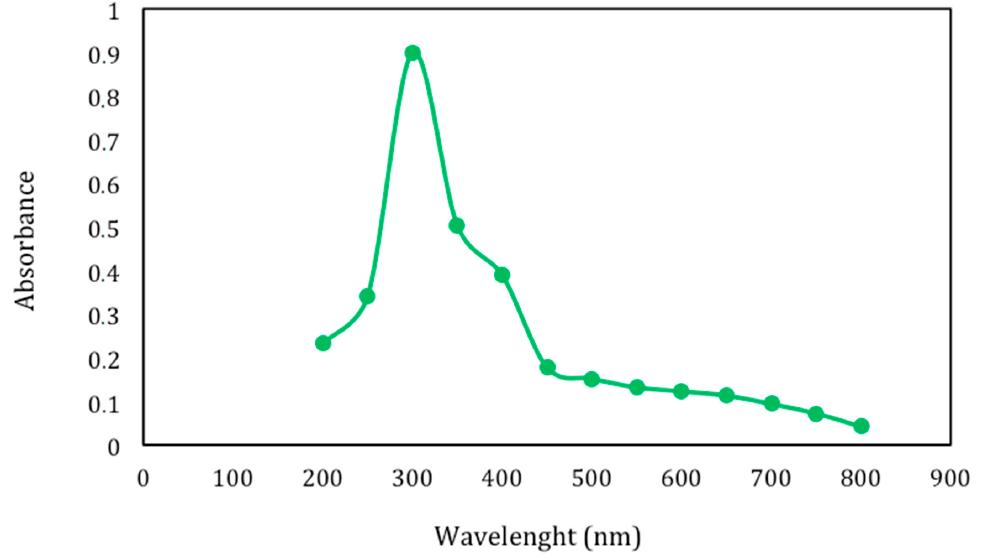
Figure 3. Absorbance at wavelengths between 200 and 800 nm of extensively dialyzed lignin fraction (0.15 mg) extracted from dewaxed egagropili powder. A proton NMR spectrum of egagropili LF was also recorded in D 2 O at pH 12, and the relative spectrum, reported in Figure 4, shows that the prevailing signals are broad peaks in the aromatic (6.5–7.5 ppm) and alkoxide (3.5–4.5 ppm) regions. The latter signal, which is due to the -OCH 3 groups on the syringyl and guaiacyl units, appeared relatively intense. This observation, indicative of the presence of additional protons of alkoxy nature, suggested checking for the possible existence of sugar residues in this fraction.